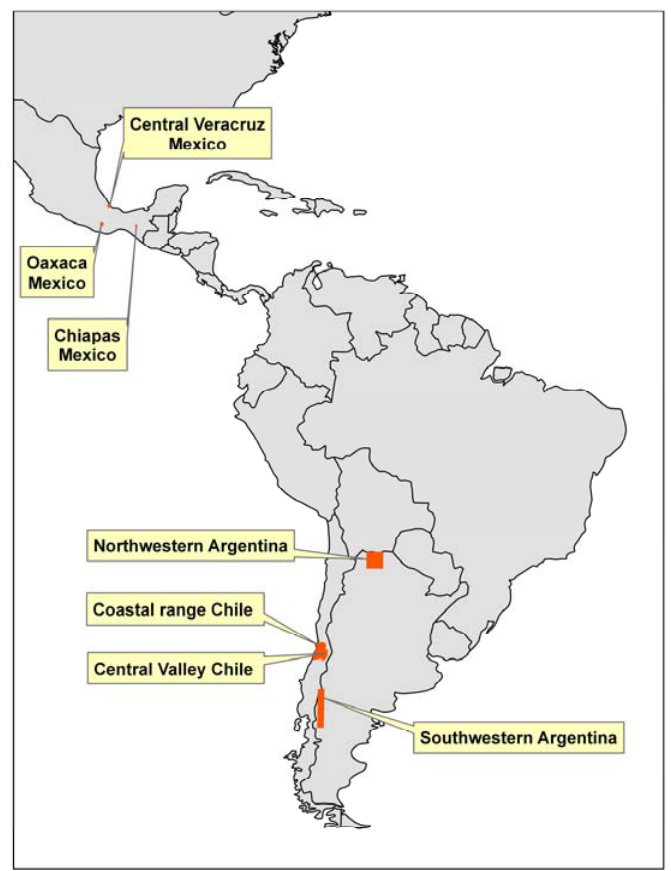
Figure 2.1 Location of the study areas included in the ReForLan project.